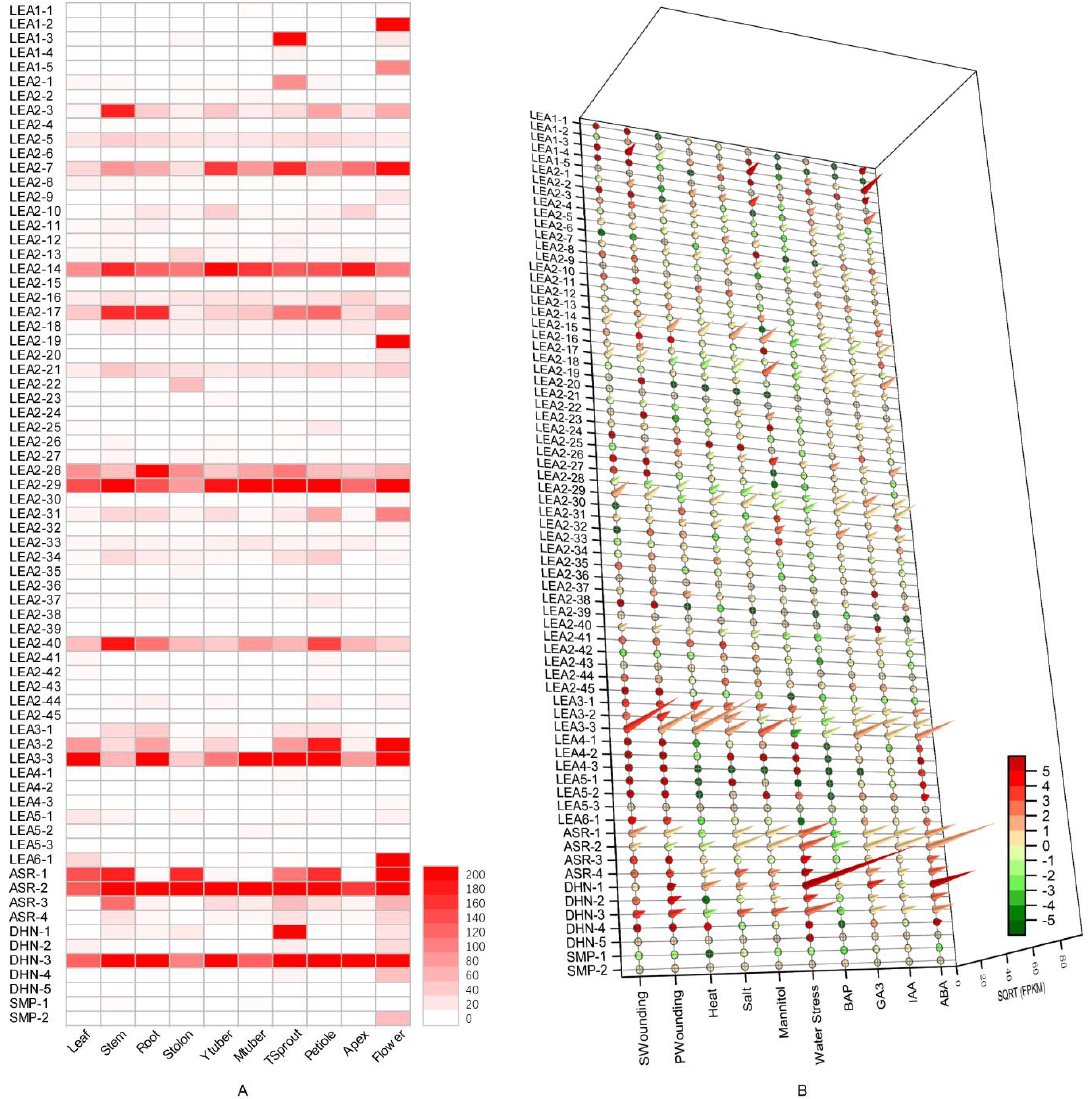
Figure 4. Expression profiling of StLEA genes in ( A ) different tissues and ( B ) under different induction conditions.